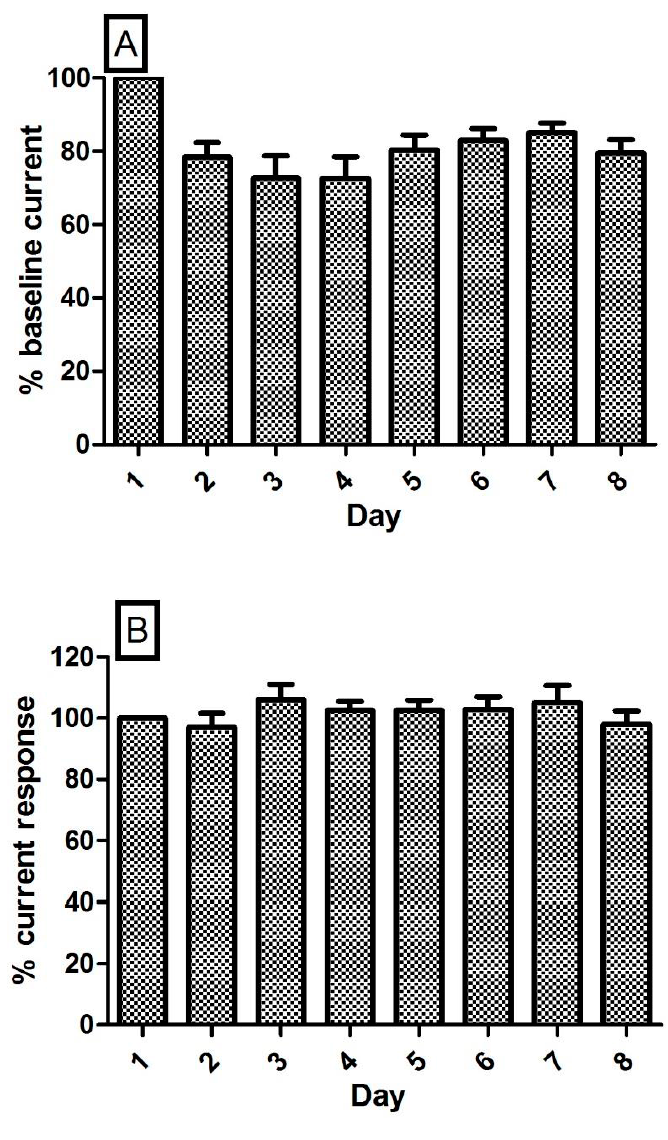
Figure 5. Average % baseline currents for ( A ) NO sensors ( n = 6) and ( B ) O 2 sensors ( n = 5) implanted in the striatum of NOD SCID mice.